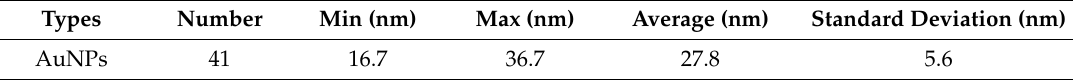
Table 2. The average particle size of AuNPs.